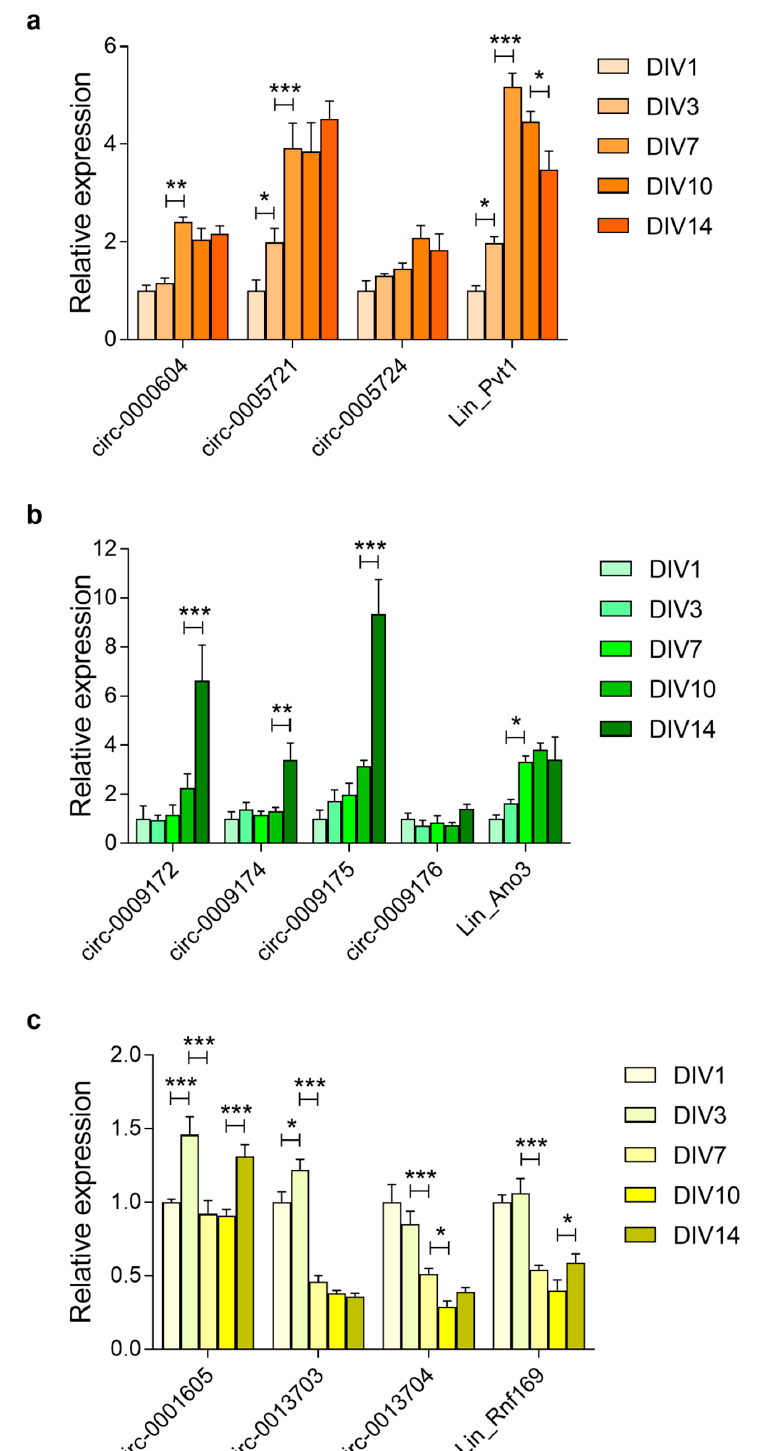
Figure 6. RNA expression during maturation of primary cortical neurons. Relative levels of linear and circular transcripts of ( a ) Pvt1; ( b ); Ano3; ( c ) Sec14l5; and, ( d ) Rnf169 in the primary cortical neurons at different days in vitro (DIV). Expression at DIV1 was set at 1. Data shown are means + s.e.m. of four biological replicates ( n = 4). Statistics were performed using two-way ANOVA; * p < 0.05; ** p < 0.01; *** p < 0.001.